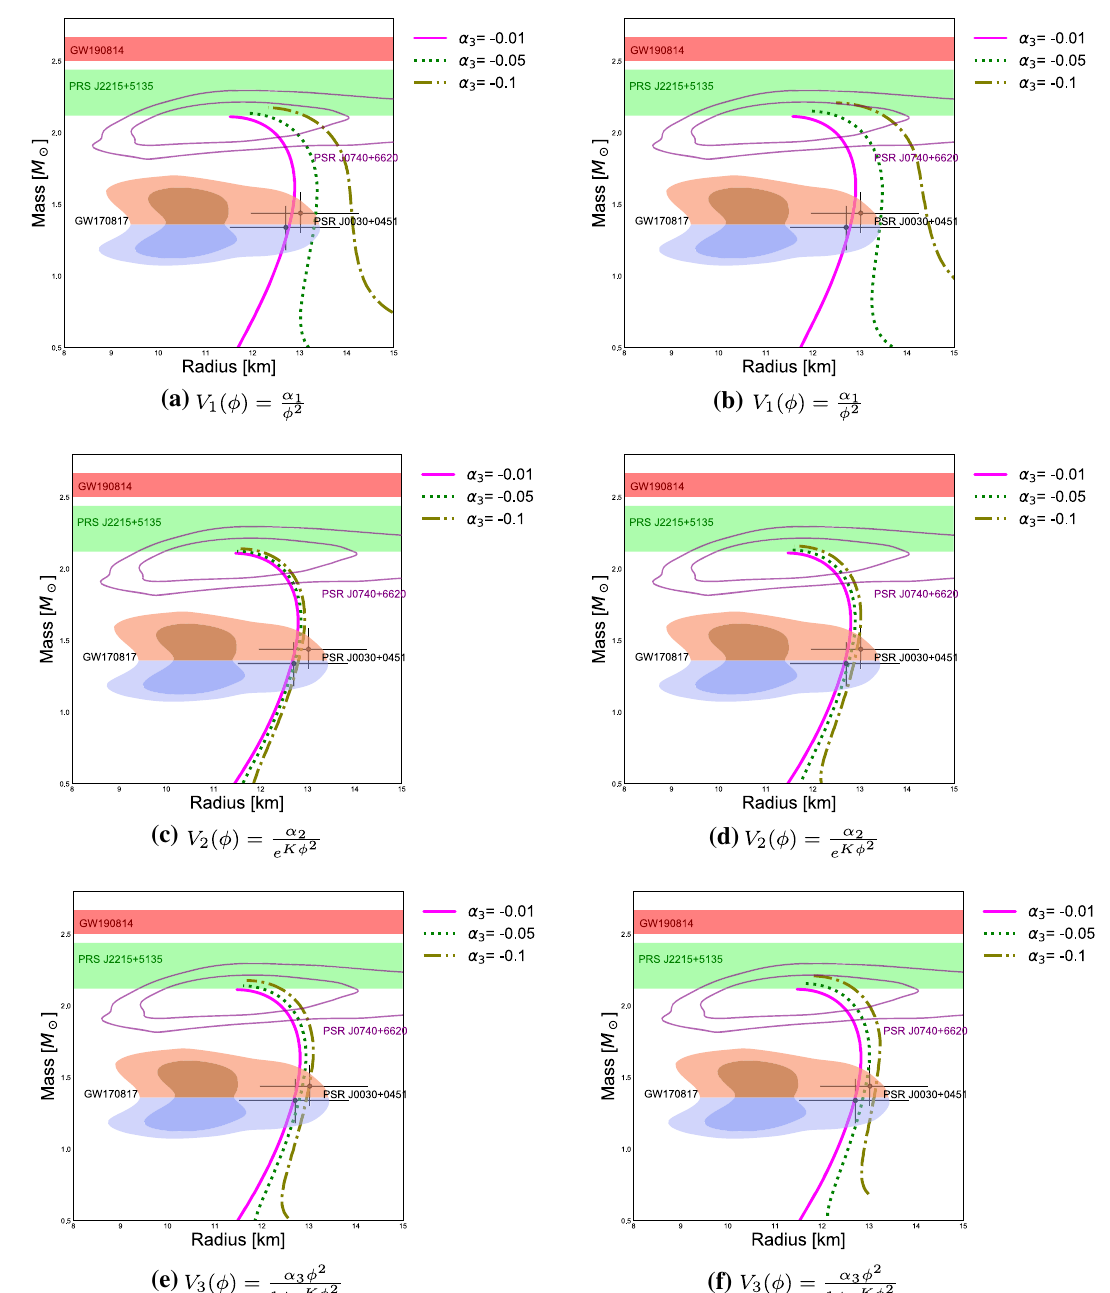
Fig. 8 The mass–radius relation of neutron stars in mimetic gravity for BH B (cid:7)φ EoS. φ( 0 ) = 1: left panels and φ( 0 ) = 0 . 8: right panels and K = 0 .